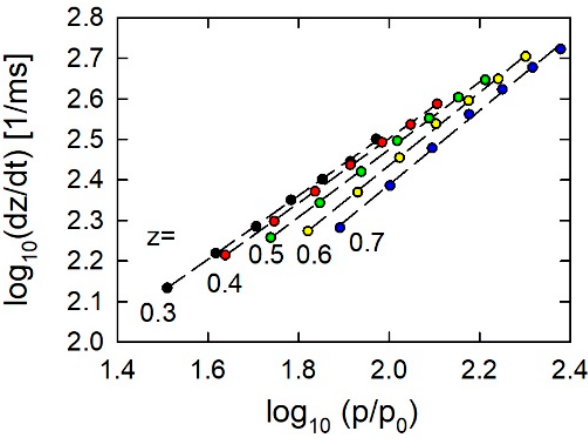
Figure 5. Plots of log 10 ( dz / dt ) versus log 10 p .